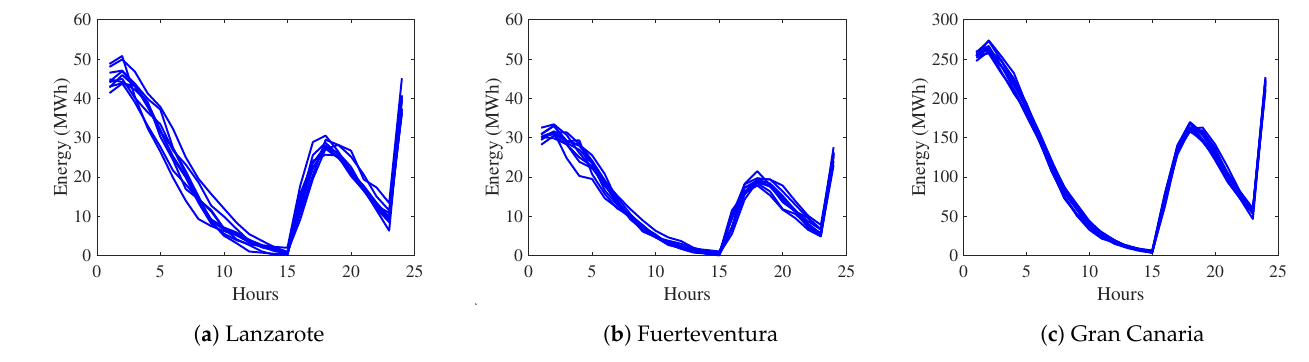
Figure 9. Electric vehicle demand.